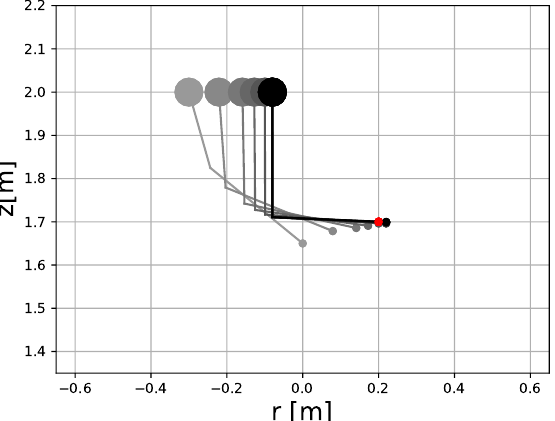
Figure 7. Error signals for the controlled end effector of the planar aerial manipulator. The dashed vertical line points out the time when the position controller is switched to force controller.